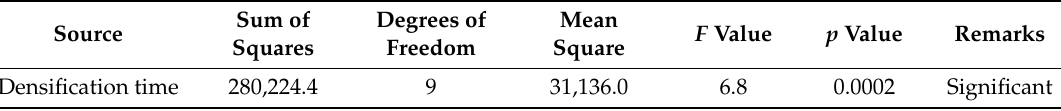
Table 1. Analysis of variance results of oven-dry density versus densification time.